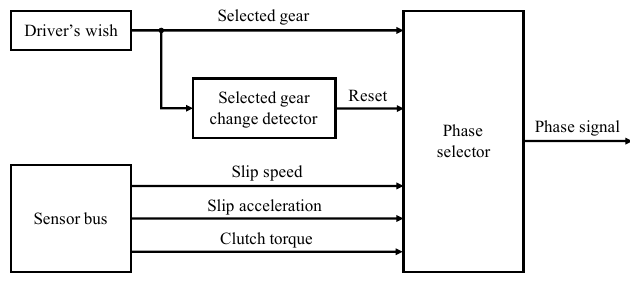
Figure 4. Phase selector.